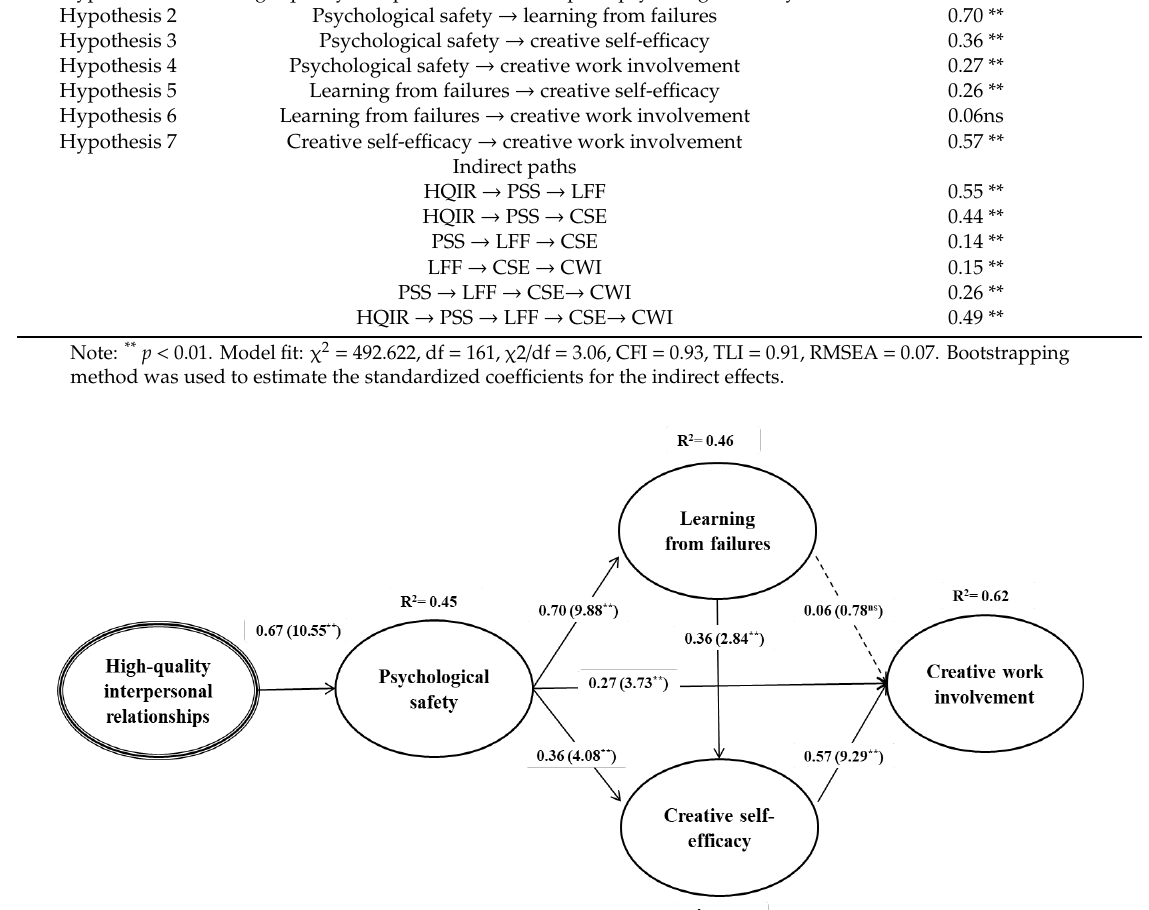
Table 5. A summary of the results that were used to test the research hypotheses.